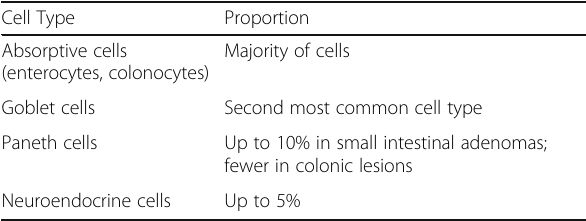
Table 3 Cell types in adenomas in Apc Min+/ − and related models